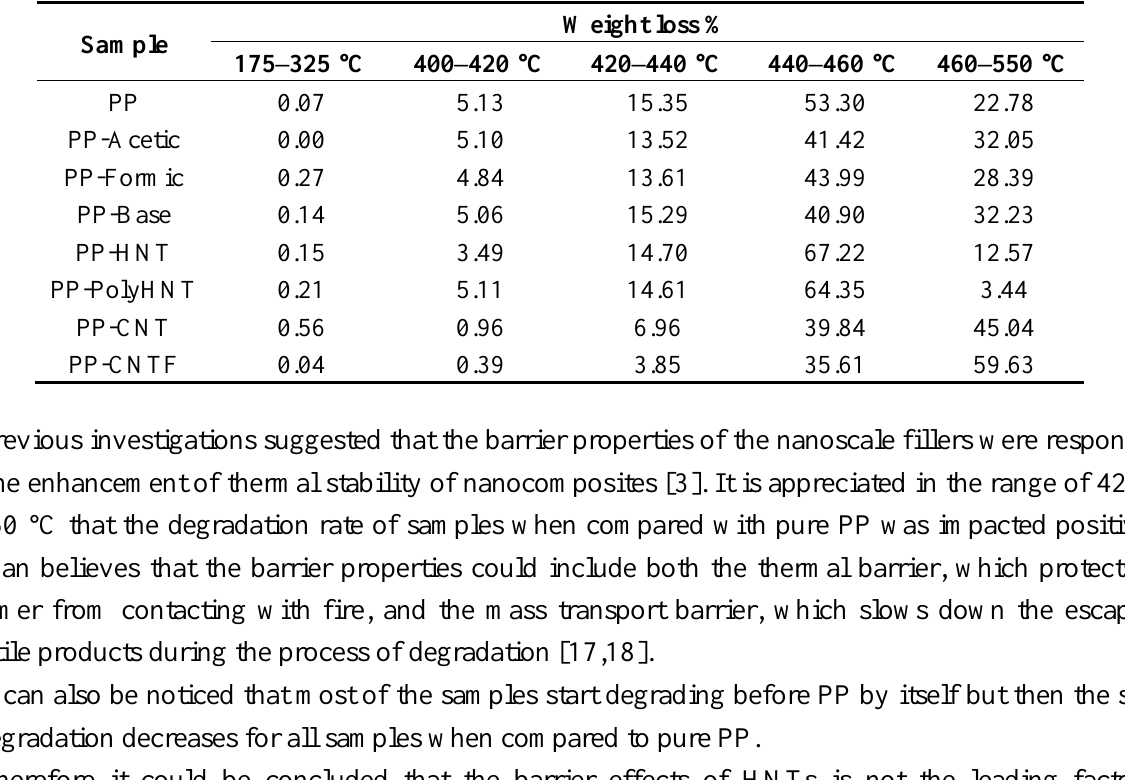
Table 4. Weight loss divided in temperature ranges where changes in weight derivate were